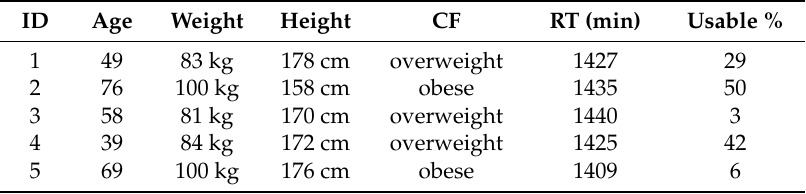
Table 4. ECG trace quality obtained with the cardio surveillance T-shirt prototype.